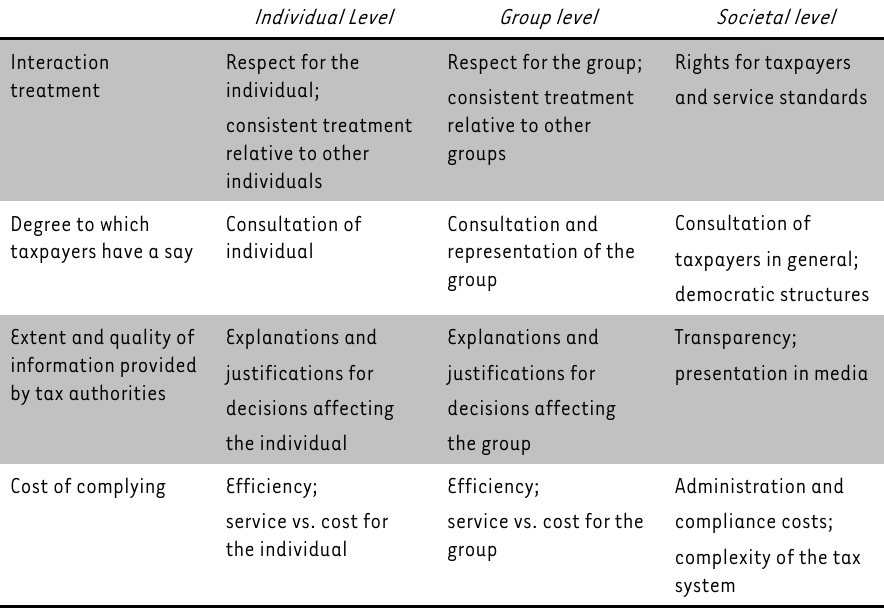
TABLE 1: Procedural justice in